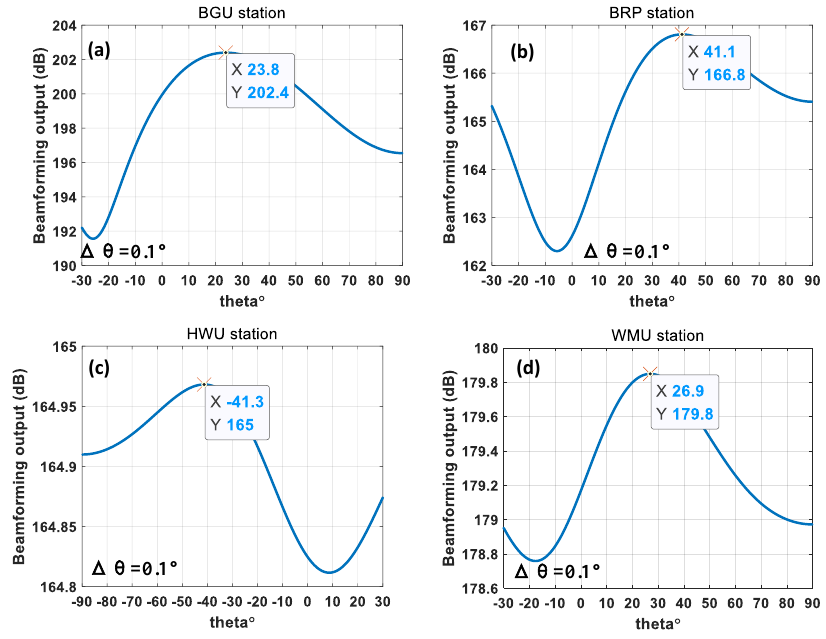
Figure 12. The results from the beamforming of the BGU, BRP, HWU, and WMU stations are ( a ) 23.8°, ( b ) 41.1°, ( c ) − 41.3°, and ( d ) 26.9°, respectively.